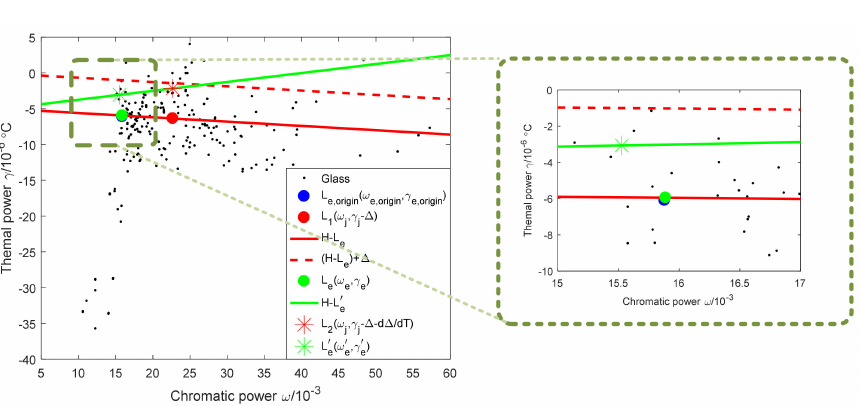
Figure 14. Final athermal map.